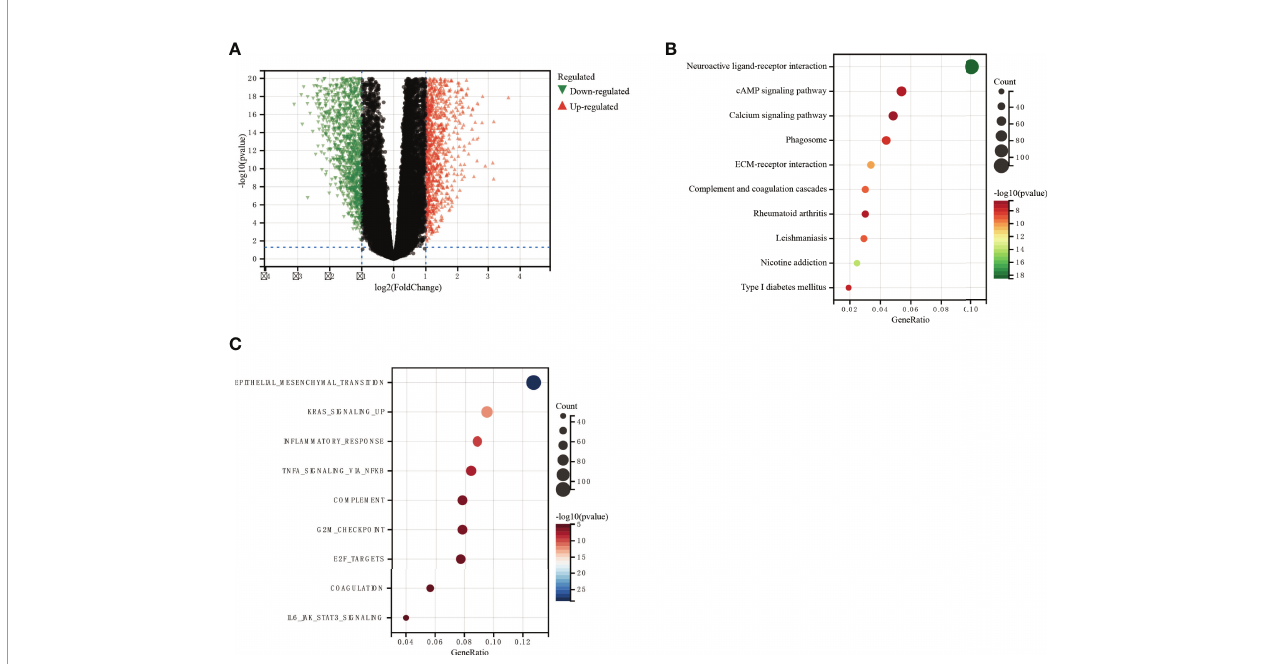
FIGURE 7 | GO and KEGG functional enrichment analysis of the role of DDOST in glioma. (A) The volcano map shows the differential genes between high- and low- DDOST groups by the CGGA 325 cohort (A) . KEGG (B) and GO (C) were used to analyze the relevant mechanisms.